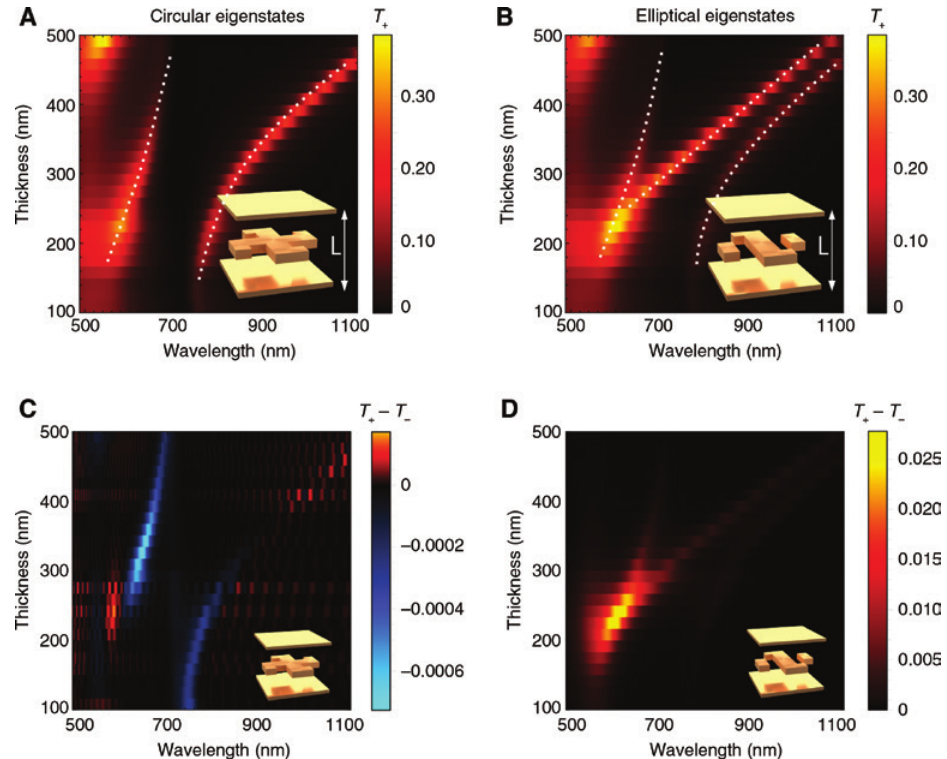
Figure 5: Effect of particle anisotropy on the mode splitting and anti-crossing under illumination with circularly polarized light. (A) Transmission spectra through an array of Au gammadions with 125 nm period placed inside the middle of an empty Fabry-Pérot cavity formed by two 20 nm thick Au mirrors as a function of the cavity thickness. Dashed lines are guides for the eye marking approximate dispersion of polariton modes. (B) The same as (A) but for an array of gammadions with removed central bar. (C) Differential transmission spectra through an array of C symmetric Au gammadions with 125 nm period placed inside the middle of an empty Fabry-Pérot cavity 4, z formed by two 20 nm thick Au mirrors as a function of the cavity thickness. (D) The same as (c) but for an array of gammadions with removed central bar yielding only C symmetry. Note the two orders of magnitude difference in values. 2, z